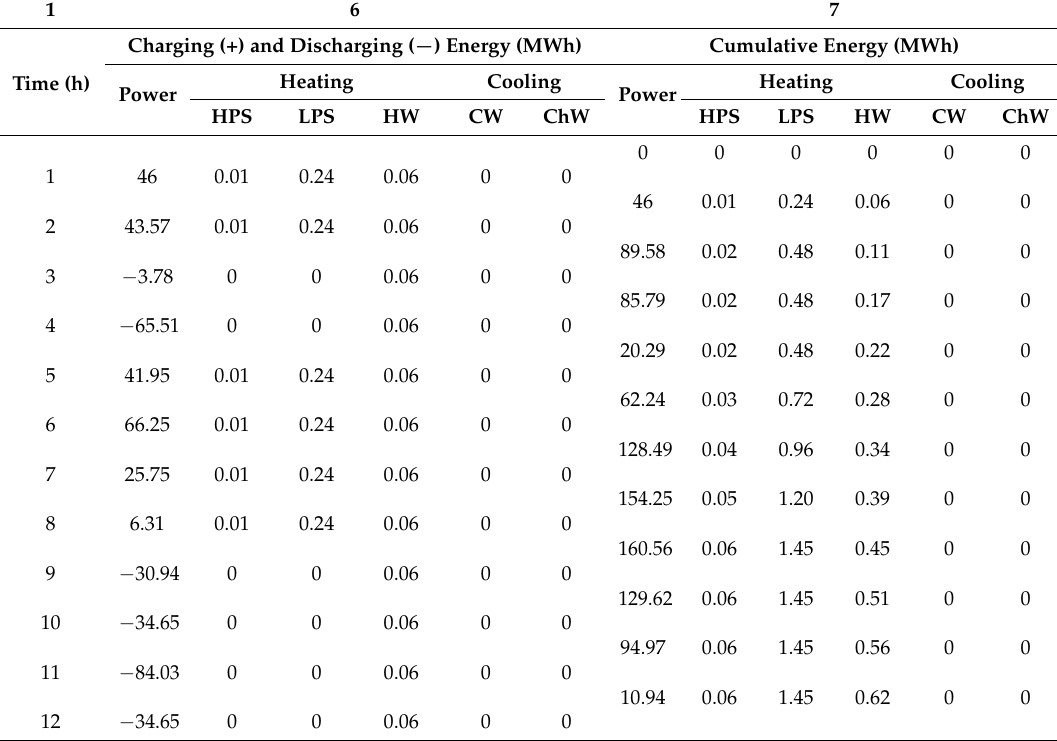
Table A13. TriGenSCA after iteration from 1 to 12 h.